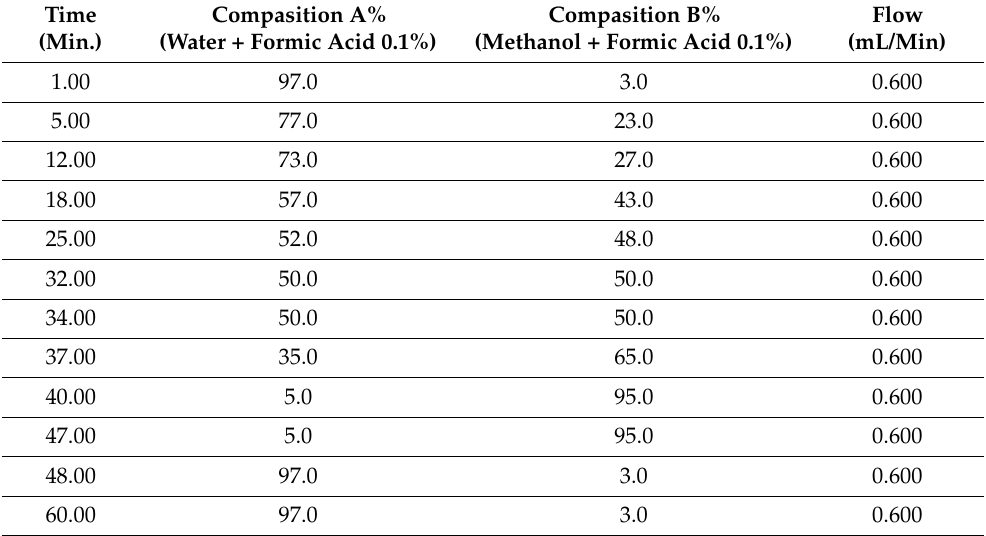
Table 5. Gradient Elution